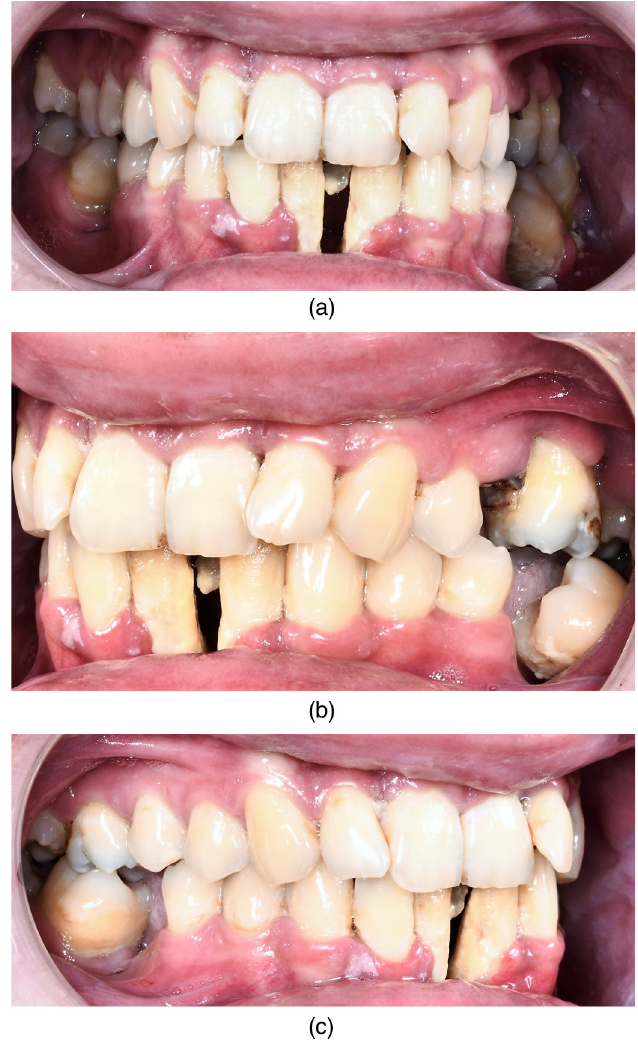
Fig. 1. Gingival in fl ammation and ulceration of papilla, predomi- nantly in anterior mandibular area. (a) Frontal view, (b) left lateral view, (c) right lateral view.